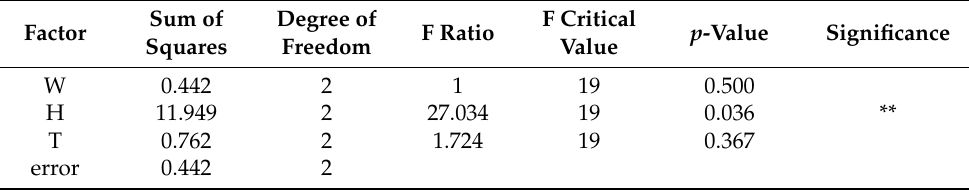
Table 5. Variance analysis of the total dry density of impregnated heat-treated wood.